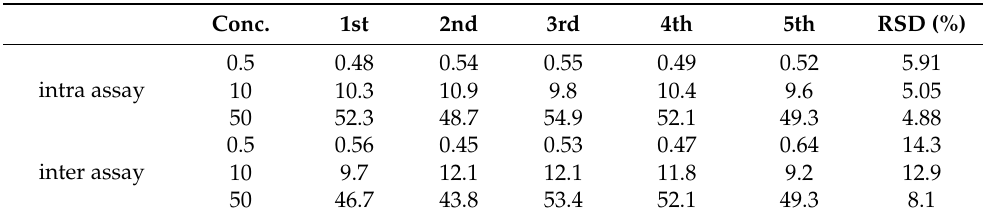
Table 1. The reproducibility of the spectrometric aptasensor on the basis of same-batch or various- batch 4-NP-aptamer/cDNA/MMSNs.